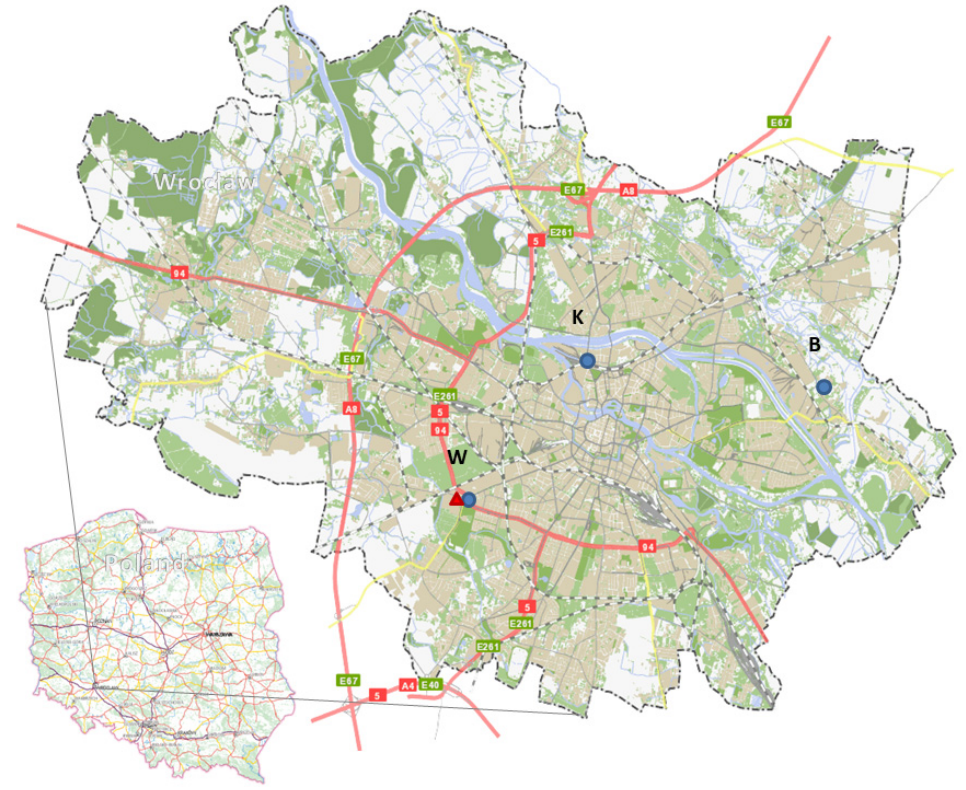
Figure 1. Wrocław city and its location on Poland map. Red triangle—traffic station, blue dots—air pollution measuring stations.